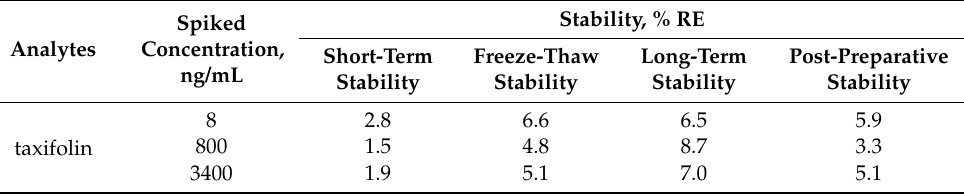
Table 3. Stability summary of taxifolin under different conditions in rat